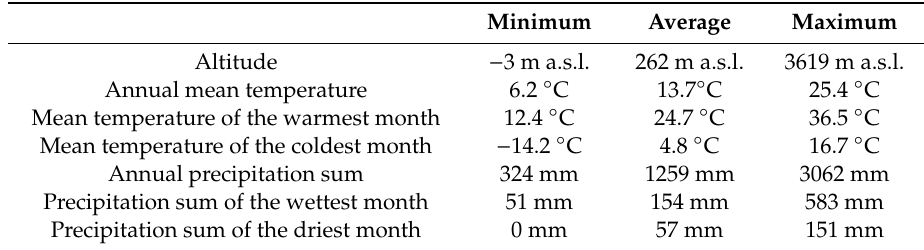
Figure 4. European climatic suitability for Fusarium circinatum based on the CLIMEX model parameters of Ganleyet al.[28] usinghigher resolution climaticdata [133]. The European distributionof non-nursery F. circinatum findings is shown as red dots in the main figure, while the inset displays the dataset used by Ganley et al. [28] in the original CLIMEX modelling. Table 2. Minimum, average and maximum values of climatic and topographical variables from the dataset of Hijmans et al. [134] and new observations of current distribution of Fusarium circinatum from the geo-database presented in the current